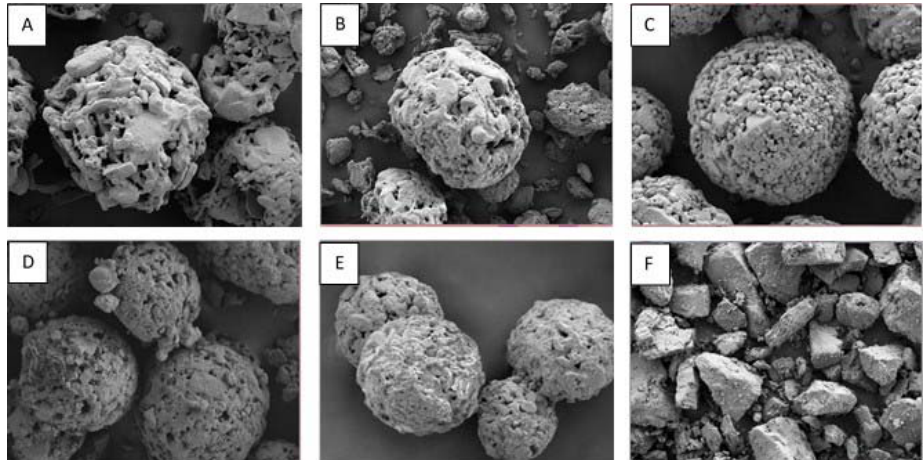
Figure 5. Scanning electron microscopy (SEM) images for lacose-based excipients: ( A ) Cellactose ® , ( B ) MicroceLac ® , ( C ) StarLac ® , ( D ) CombiLac ® ( E ) FlowLac ® 100 and ( F ) Crystalline lactose monohydrate (GranuLac ® ). From Meggle Company website [97].